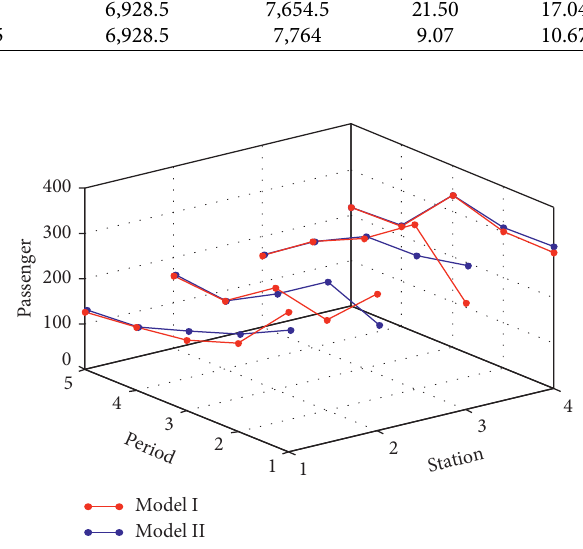
Figure 7: Comparison of controlled passengers in two models.